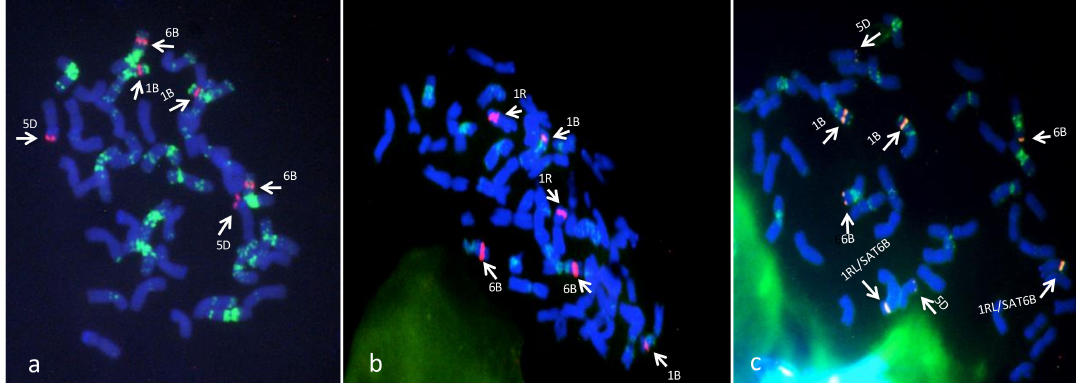
Figure 3. Double target FISH analysis with rDNA pTa71 probe (red) and (GAA) 7 oligonucleotides (green) on N11 ( a ), XY7 ( b ) and N11 XY7 ( c ) metaphase spreads. Chromosome rDNA localization is indicated by